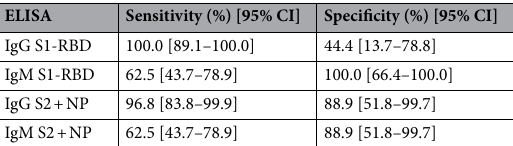
Table 3. Sensitivity and specificity of IgG and IgM ELISAs at identifying a PRNT 80 titre of ≥ 1:40.